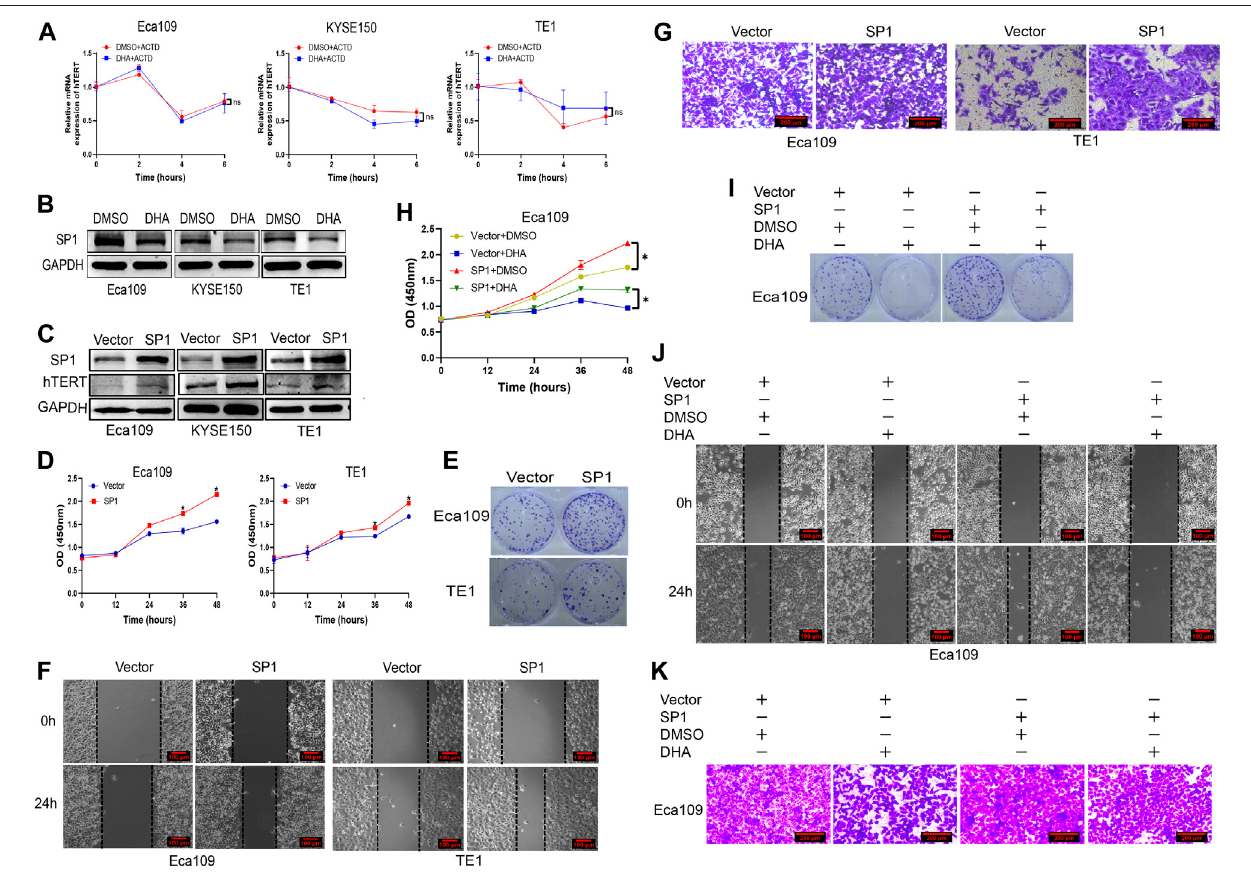
FIGURE 4 | DHA downregulates the expression of hTERT in esophageal cancer through inhibiting transcriptional factor SP1. (A) The effect of DHA on hTERT mRNA stability in Eca109, KYSE150, and TE1 cells evaluated by actinomycin D assays. (B) DHA downregulates the expression of transcription factor SP1 in Eca109, KYSE150, and TE1 cells. (C) Overexpression of SP1 enhances the expression of hTERT. (D,E) Overexpression of SP1 promoted the proliferation of Eca109 and TE1 cellsdeterminedbytheCCK8 (D) andplatecolonyformationassays (E) . (F,G) OverexpressionofSP1promotedthemigrationofEca109andTE1cellsdetermined bythescratch (F) andtranswellassays (G) . (H,I) TheproliferationofSP1-overexpressingEca109cellsaftertreatedwithDHAandmeasuredbytheCCK8 (H) andcolony formation assays (I) . (J,K) The migration of SP1-overexpressing Eca109 cells after treatment with DHA and evaluated by scratch assay (J) and transwell assay (K) . (* indicate p < 0.05 compared with